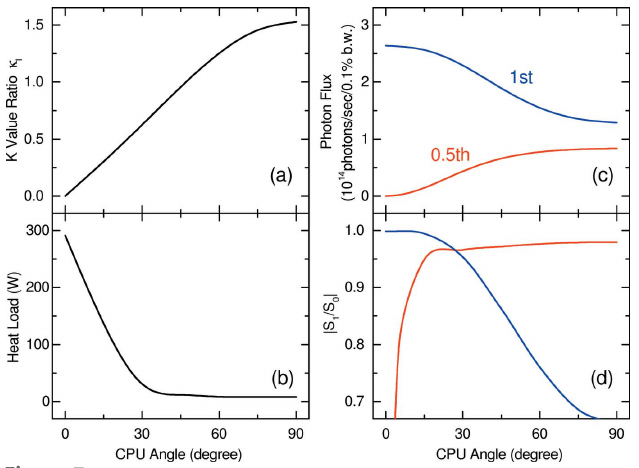
Figure 7 Light source performances plotted as a function of the CPU angle (cid:5) : ( a ) K value ratio (cid:6) l , ( b ) heat load, ( c ) photon flux and ( d ) polarization.